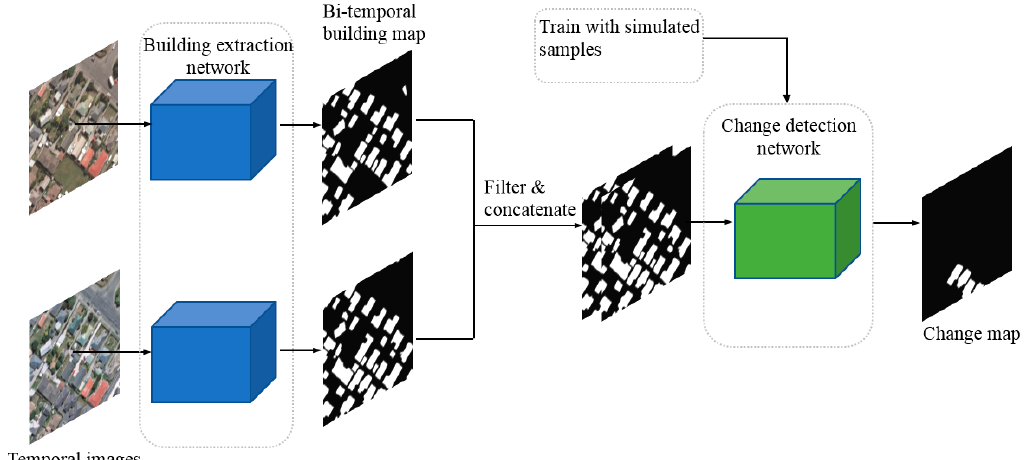
Figure 1. Overview of our classification-based change detection framework.